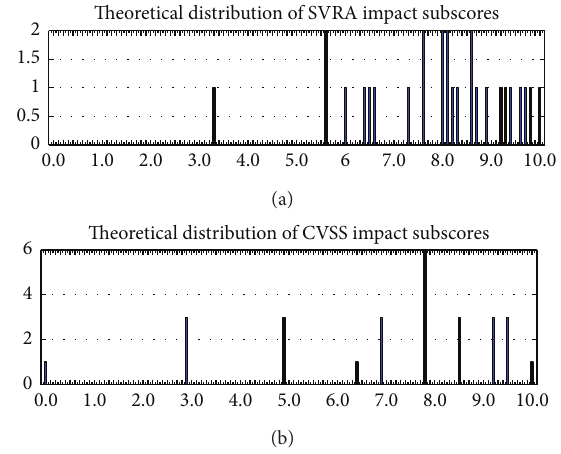
Figure 5: Theoretical distributions of impact subscores for SVRA (a) and CVSS v2 (b), where 𝑇 = {2002, 2003, . ..} and 𝑡 = 2012 .